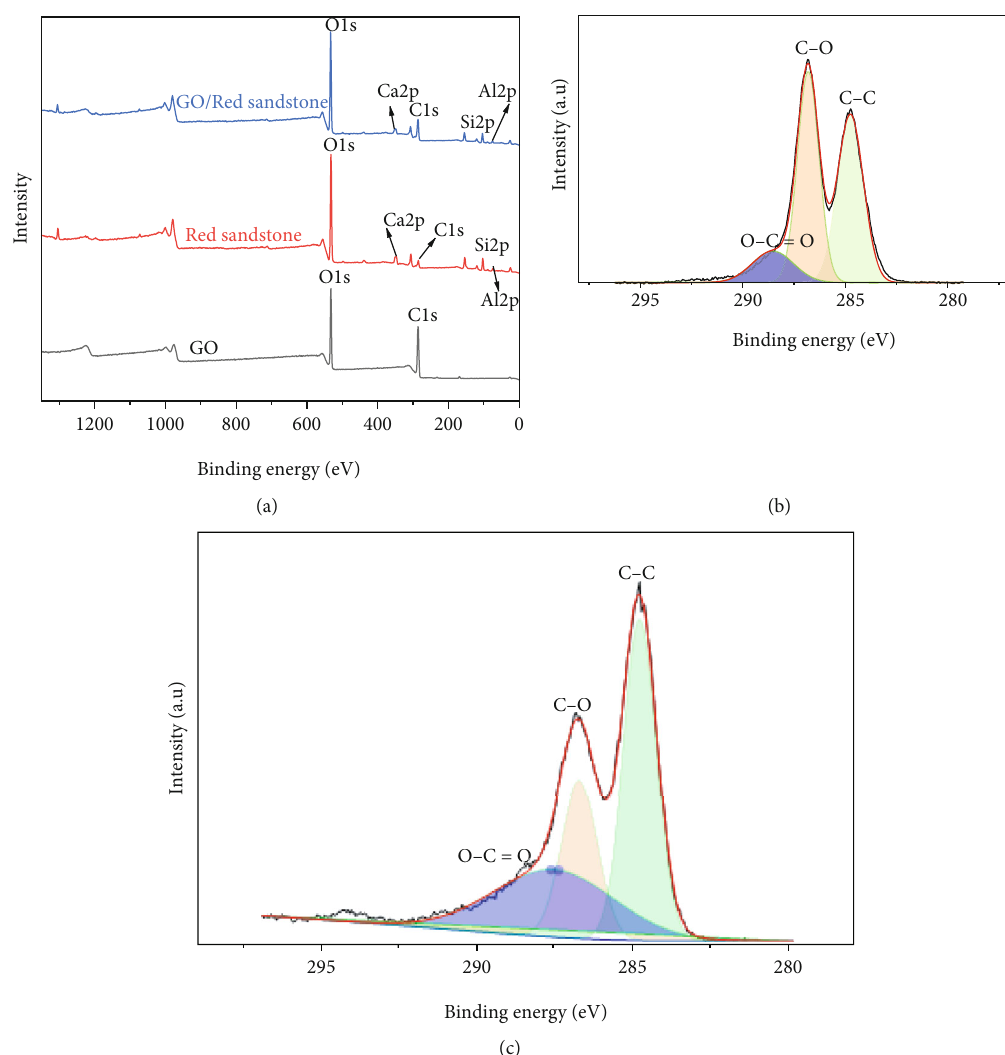
Figure 5: (a) XPS spectra of GO, red sandstone, and GO/red sandstone; (b) C1s XPS spectra of GO; (c) C1s XPS spectra of GO/red